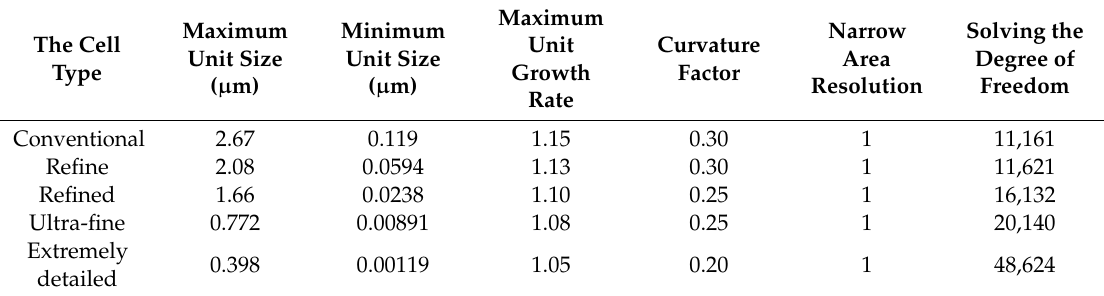
Table 3. The grid division scales.